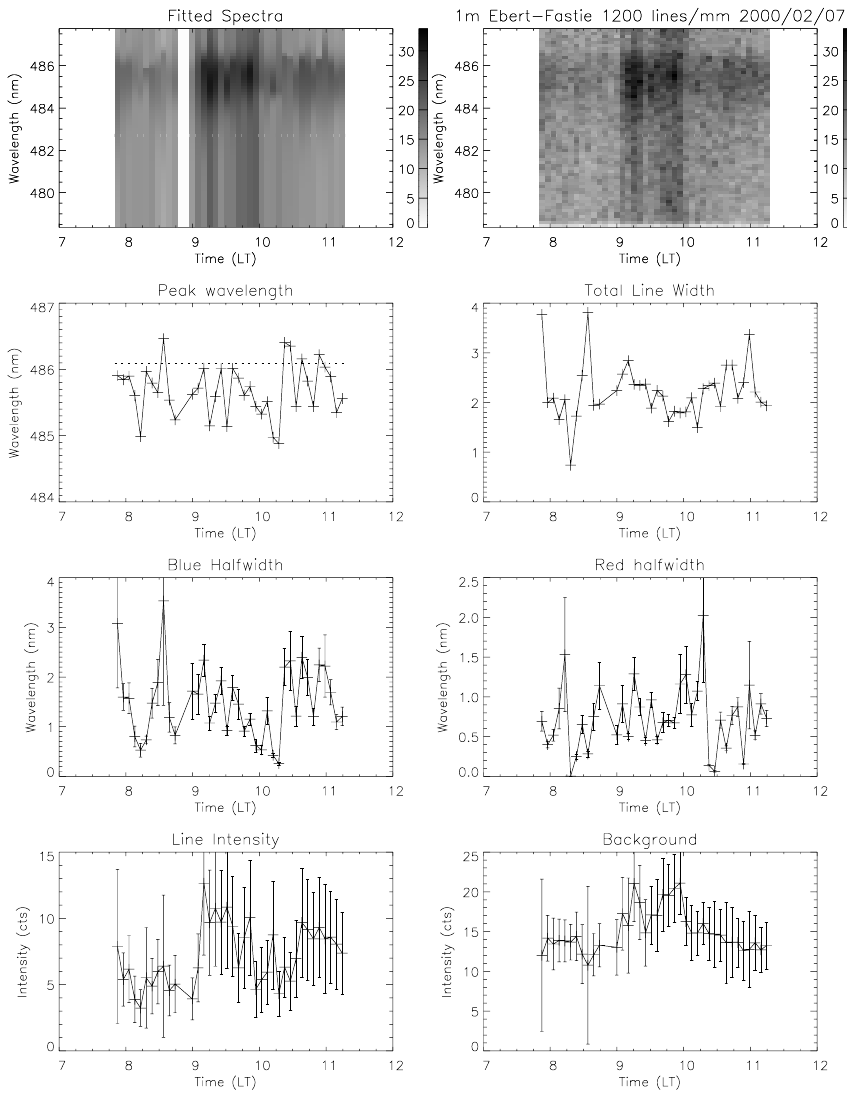
Fig. 5. H- β spectra observed along the magnetic field line with a 1-m Ebert-Fastie spectrometer at Poker Flat on 7 February 2000. The time variation of different quantities related to the line shape and brightness are also